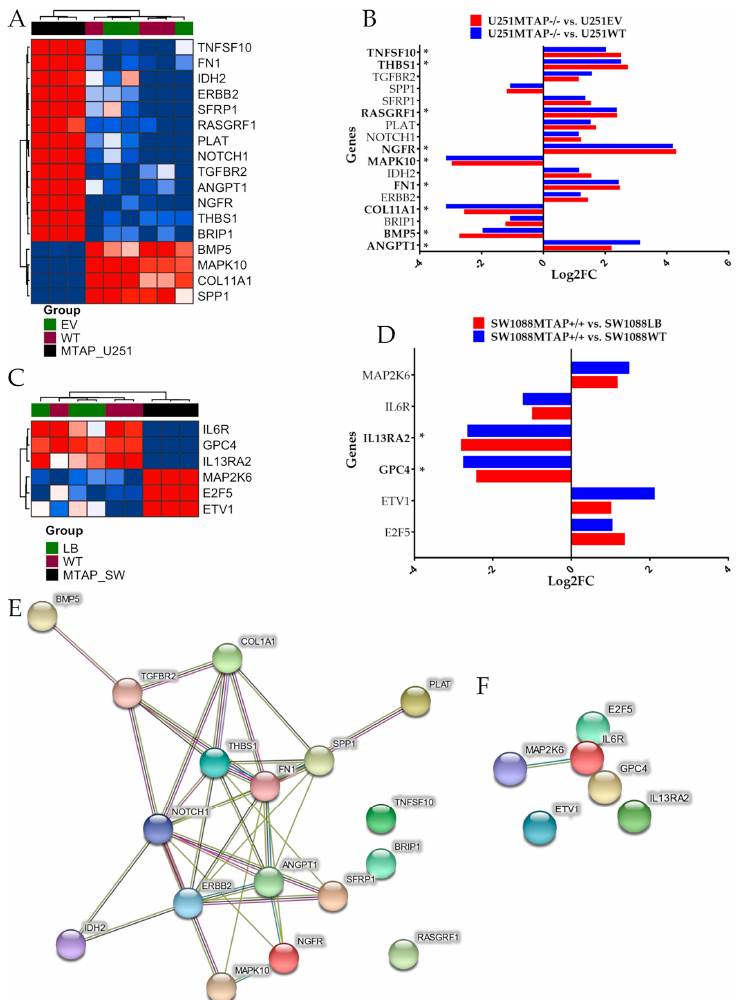
Figure 5. Detection of differentially expressed genes affected by MTAP gene-edited in glioma cell lines. ( A ) Heatmap representing the expression profile of the most differentially expressed genes for U251MTAP − / − cell compared to U251EV and U251WT cells. ( B ) Bar plots showing gene expression as the mean SD of log changes of U251MTAP − / − relative to U251EV and U251WT cells. ( C ) Heatmap representing the expression profile of the most differentially expressed genes for SW1088MTAP+/+ cell compared to SW1088LB and SW1088WT cells. ( D ) Bar plots showing the gene expression as the mean SD of log changes of SW1088MTAP+/+ relative to SW1088LB and SW1088WT cells. ( E , F ) Isolated networks of protein − protein interaction using STRING (http://www.string-db.org). The weight of these lines represents the confidence within which a predicted interaction occurs. Interactions networks for 17 and six proteins di ff erentially regulated in U251MTAP − / − and SW1088MTAP +/+ cells compared to controls U251EV and SW1088LB, respectively. Rows represent genes and columns represent cell lines. Red pixels: upregulated genes; blue pixels: downregulated genes. The intensity of each color denotes the standardized ratio between each value and the average expression of each gene across all samples. Each sphere represents an individual protein, and edges represent protein–protein associations. A red line indicates the presence of fusion evidence; a green line indicates neighborhood evidence; a blue line indicates co-occurrence evidence; a purple line indicates experimental evidence; a yellow line indicates text-mining evidence; a light blue line indicates database evidence; and a black line indicates co-expression evidence. Asterisks (*) labeling the bar indicates a significant di ff erence ( p -value < 0.05 and log 2 FC ≥± 2) between the gene expression of respective groups and the control. The network nodes represent proteins. Edges represent protein–protein associations. Student t-test: * p < 0.05, ** p < 0.01, *** p < 0.001, ns : not